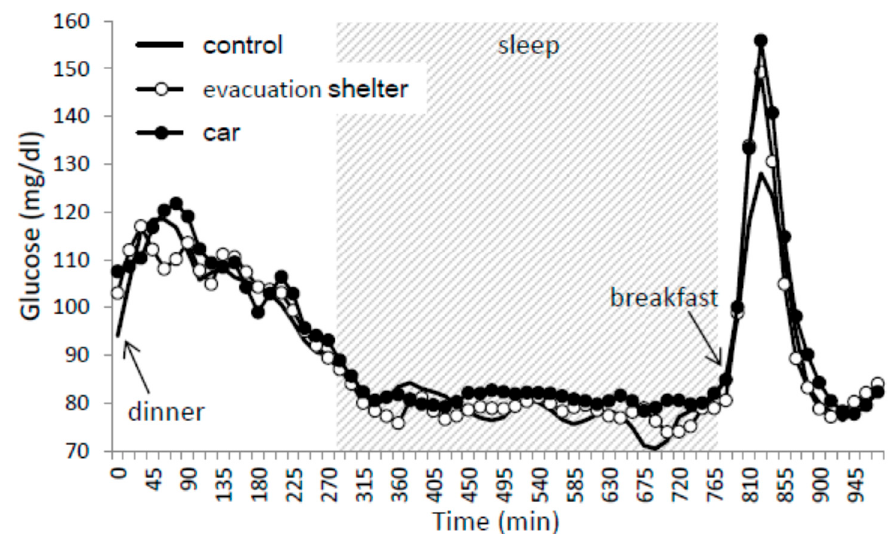
Figure 2. Time course of glucose from dinner to 3 h after breakfast. Mean values of blood glucose for nine subjects were plotted every 15 min. The black lines show data for the control trial, the open circles show data for evacuation shelter trials, and the closed circles show data for the car trial. Sleep hours are indicated in the gray zone. Table 4. Results of glucose indices ( n = 9).